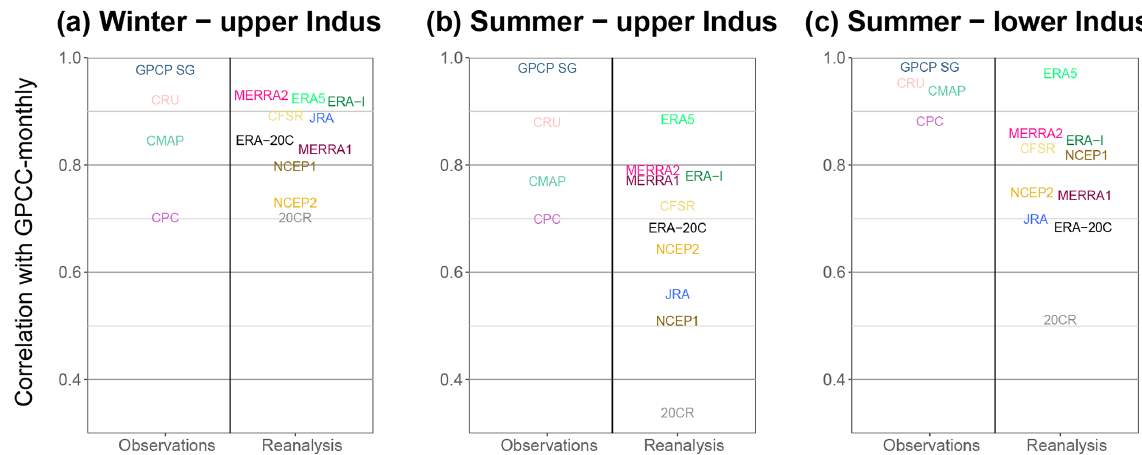
Figure 10. Inter-annual correlation on the period 1981–2010 between GPCC-monthly and the other datasets covering that period. The correlations are computed for specific seasons and domains. We split the result by type of dataset (observation and reanalysis).